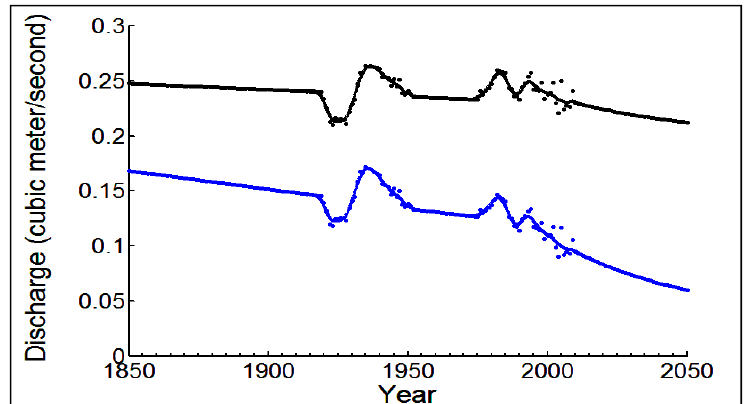
Figure 14. Modeled hydrographs for QUE, showing mean yearly (black) and mean dry season (blue) discharge from the hydro balance model. Dots represent yearly individual results and the lines are smoothed using a smoothing spline parameter of 0.214.